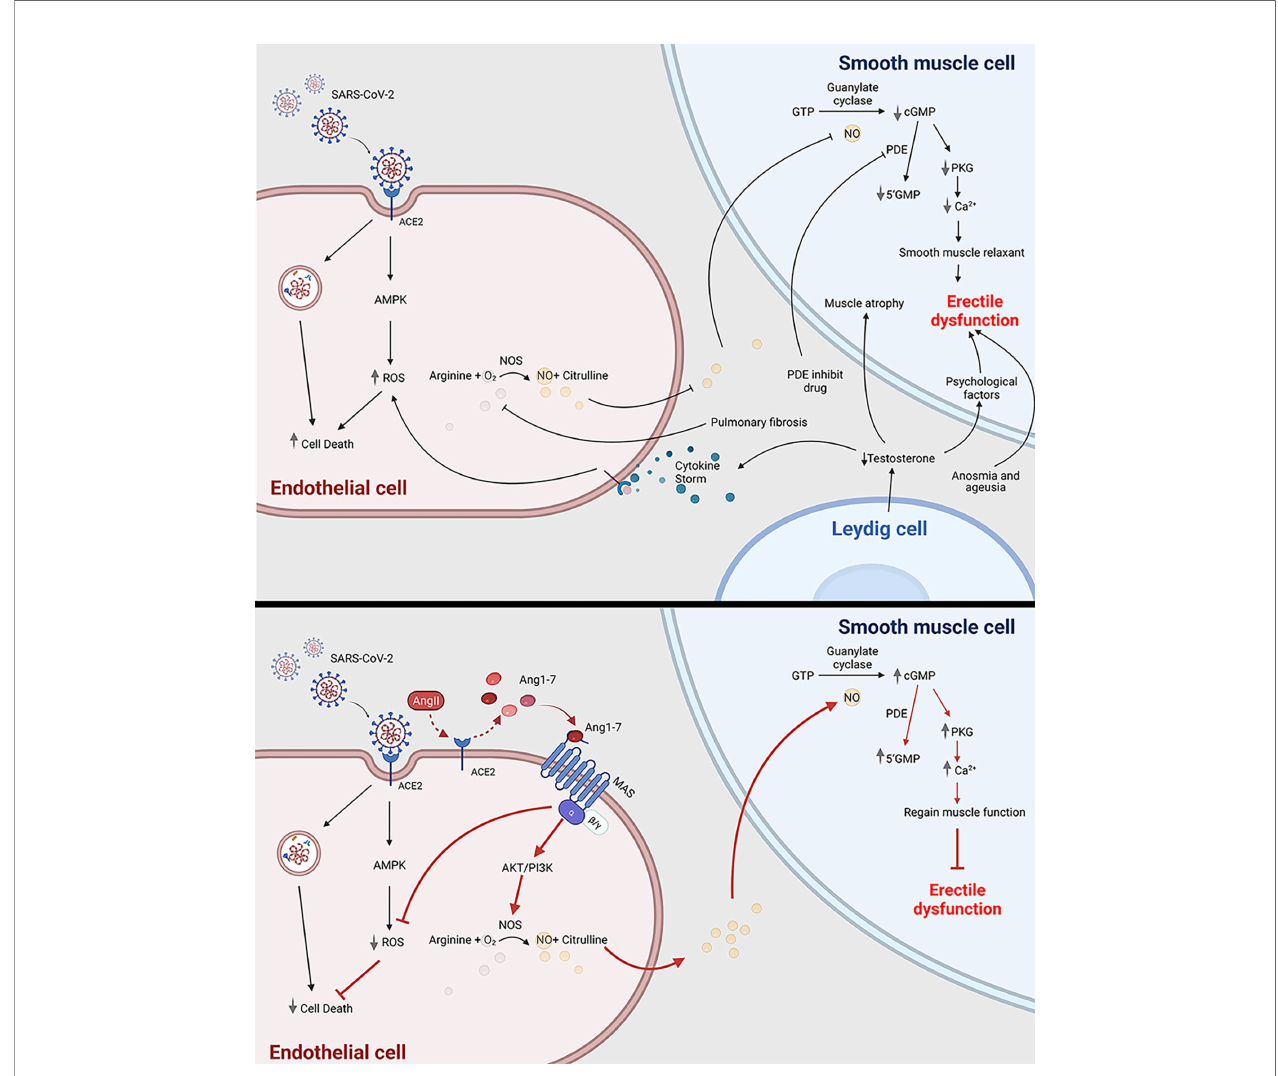
FIGURE 1 | COVID-19 can cause erectile dysfunction. The potential mechanism of how COVID-19 infection is related to erectile dysfunction through impairing endothelial cell and smooth muscle cell (top panel); Ang1-7 is a potential novel drug target to treat erectile dysfunction in COVID-19 patients (bottom panel). ACE2, angiotensin-converting enzyme 2; SARS-CoV-2, severe acute respiratory syndrome coronavirus 2; ED, erectile dysfunction; ROS, reactive oxygen species; AMPK, AMP-activated protein kinase; Ang1-7, angiotensin 1-7; Ang II, angiotensin 2; PDE, phosphodiesterase; 5 ’ GMP, Guanosine-5 ’ -monophosphate; cGMP, cyclic guanosine monophosphate; PKG, Cyclic GMP – dependent protein kinase; NOS, nitric oxide synthase. This scheme was created using BioRender, accessed on Sept. 29,